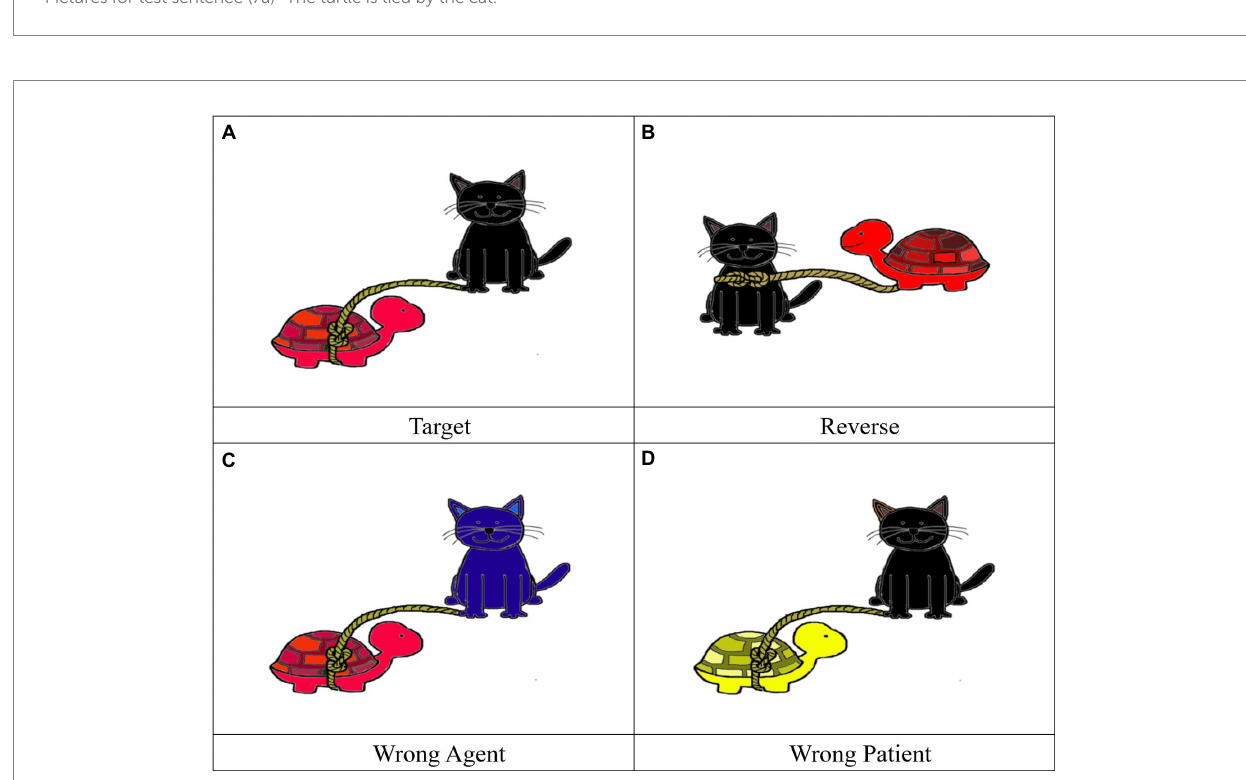
FIGURE 2 Pictures for test sentence (7b) “The red turtle is tied by the black